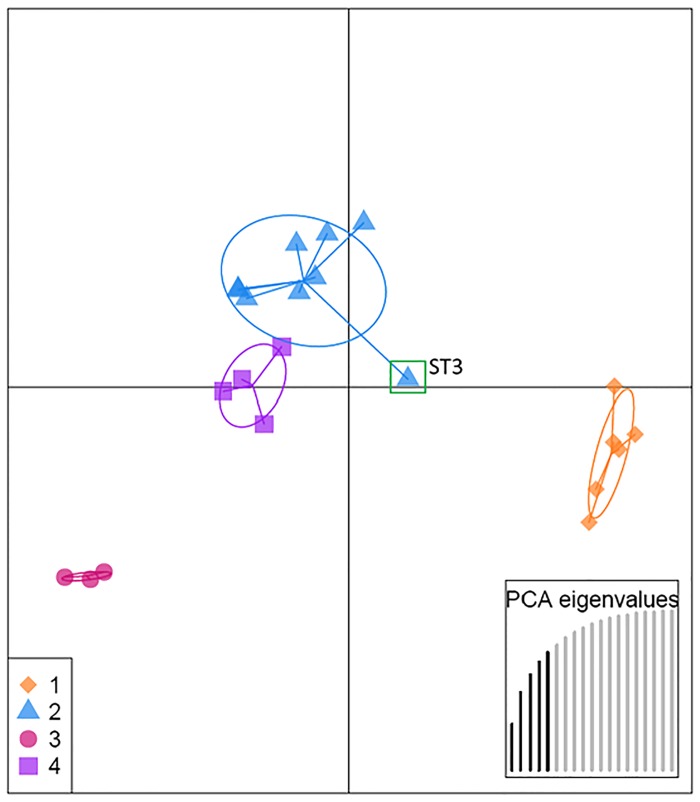
A scatterplot of the discriminant analysis of principal components (DAPC) of B. goodwinii Sequence Types, showing four clusters of STs.Only the first two principal components of the DAPC are shown (horizontal and vertical axes, respectively). Green rectangle indicates ST3 which is estimated to be an admixed genotype by STRUCTURE with the cluster assignment ratio at 50:50% (Fig 5).